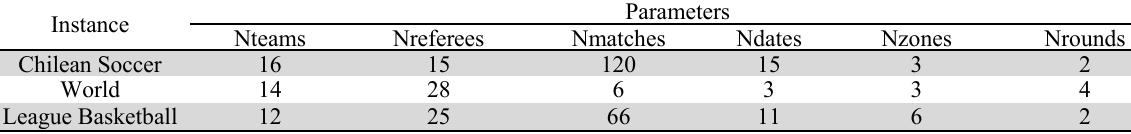
Chilean national Soccer